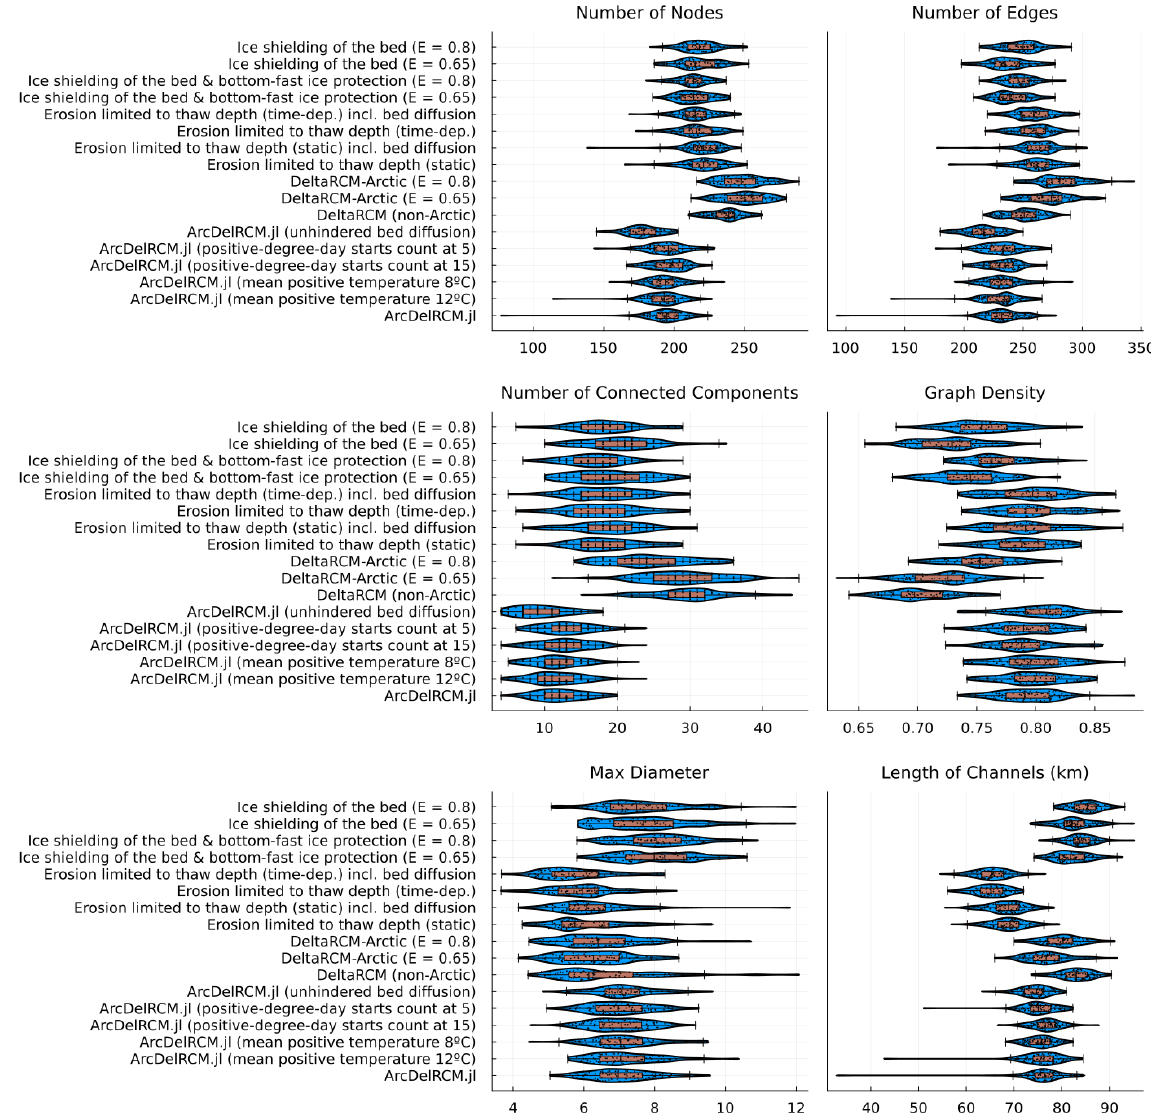
Figure 6. Plots showing delta metrics determined by the graph analysis we performed on each of the configurations described in Sect. 3.2. The blue violin plots show the kernel density estimate, the orange box and whisker plots show the central 50%, maximum, median, and minimum values, and the black dots show the actual values of the individual simulations. The labels along the vertical axes correspond to the titles of each panel in Fig. 5. The metrics of the variant cases not explicitly shown in this text (i.e. all cases with E = 0 . 65, ArcDelRCM.jl with unhindered bed diffusion, and the non-Arctic DeltaRCM) are included for